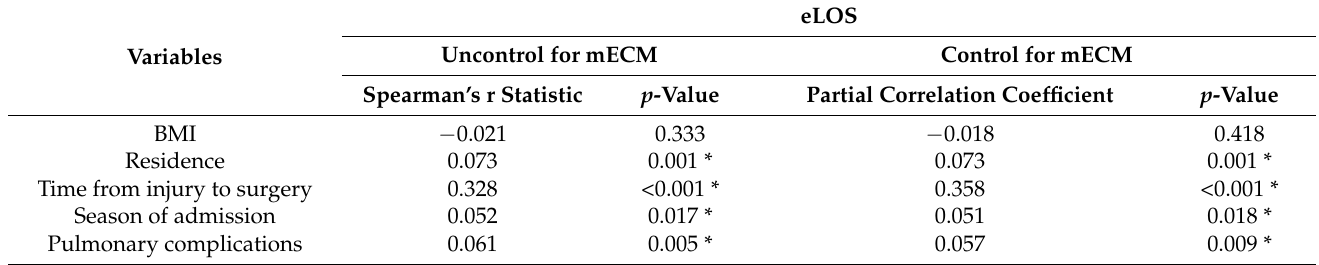
Table 3. The association between eLOS with the identified risk factors influenced by patient comor- bidities, which are recorded and measured as